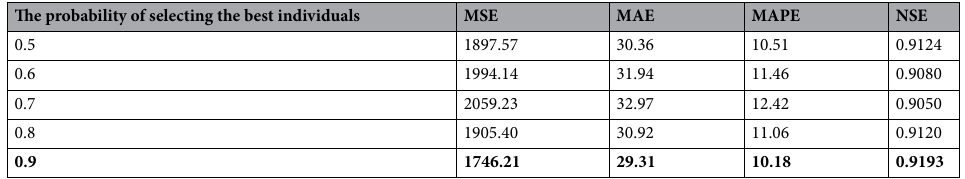
Table 6. Impact of selecting best individuals of generation probability. Best results are highlighted in bold text. Selecting the best individual with the probability of 0.9 get the best performance.